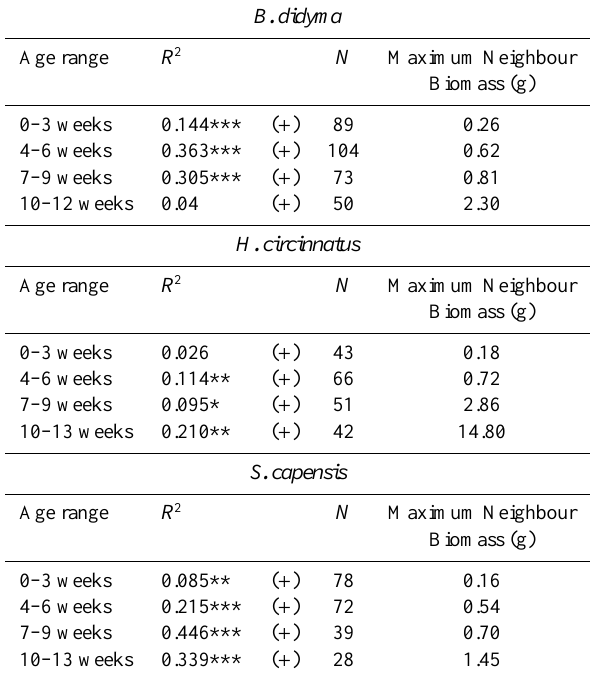
Table 2. Coe ffi cient of determination values for linear regressions of plant interaction intensity (RII – Relative Interaction Index) on neighbour biomass at di ff erent age ranges. Interaction intensity was calculated on pooled population data for Biscutella didyma , Stipa capensis and Hymenocarpos circinnatus . The signs of the correla- tions are shown next to each R 2 value. Sample size and maximum neighbour biomass at each age range are also presented. * P < 0 . 05, ** P < 0 . 01, *** P < 0 .